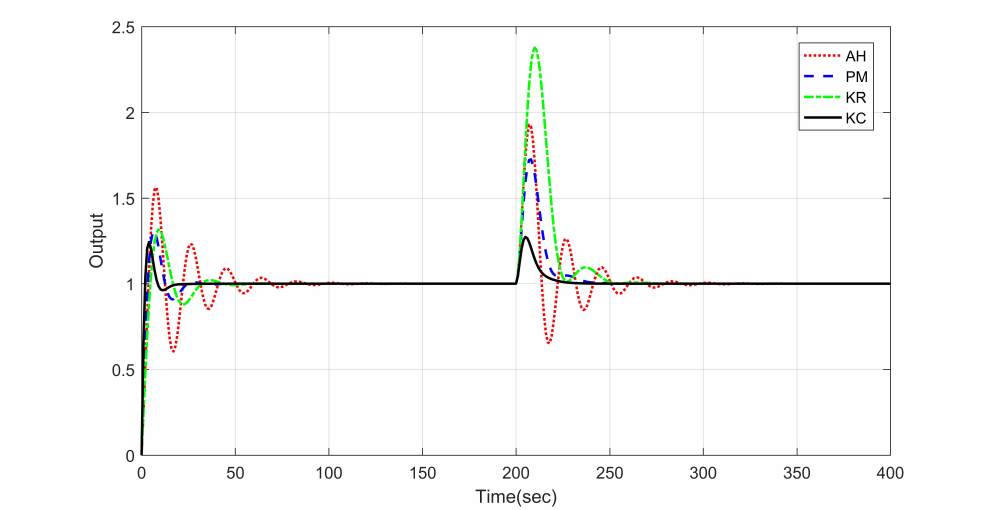
Figure 7. The results of a SISO system with different PID